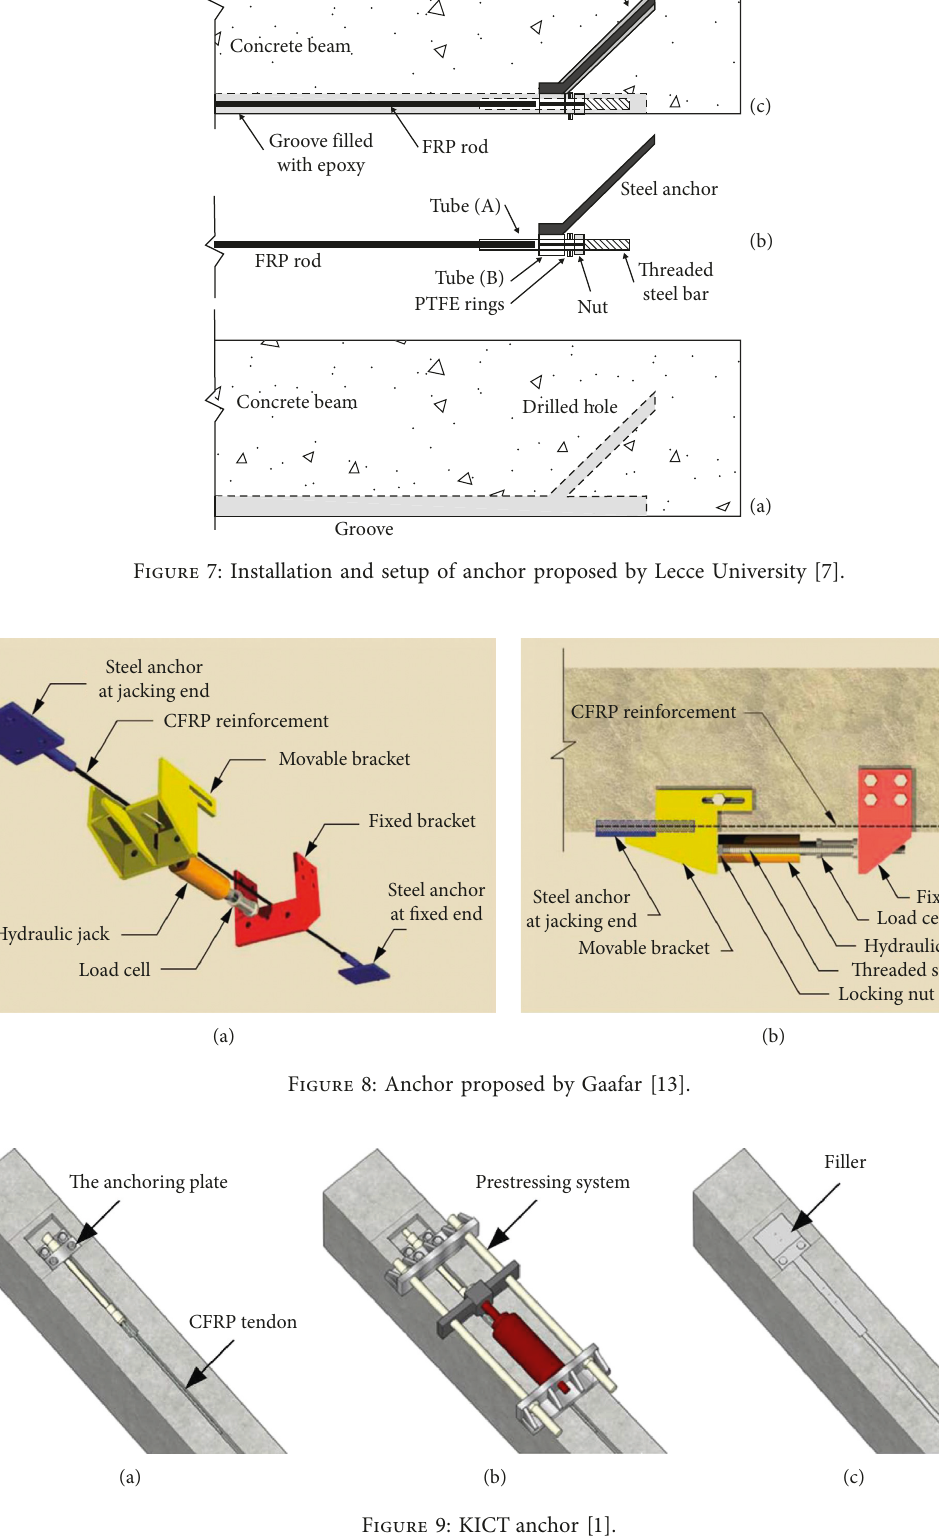
Figure 9: KICT anchor